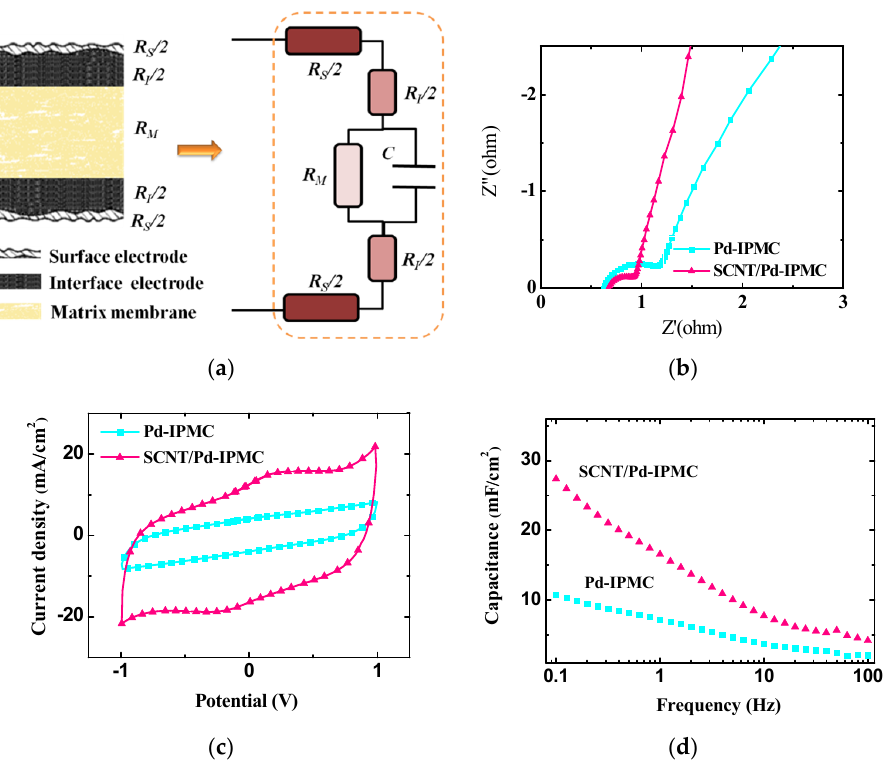
Figure 6. Electrochemical properties of the IPMCs. ( a ) Equivalent circuit of IPMC with SCNT/Pd electrode ( R S is the surface electrode resistance, R I is the interface electrode resistance, R M is the membrane resistance, C is the capacitance); ( b ) Nyquist plot; ( c ) CV curves; ( d ) frequency dependence of the differential capacitance.